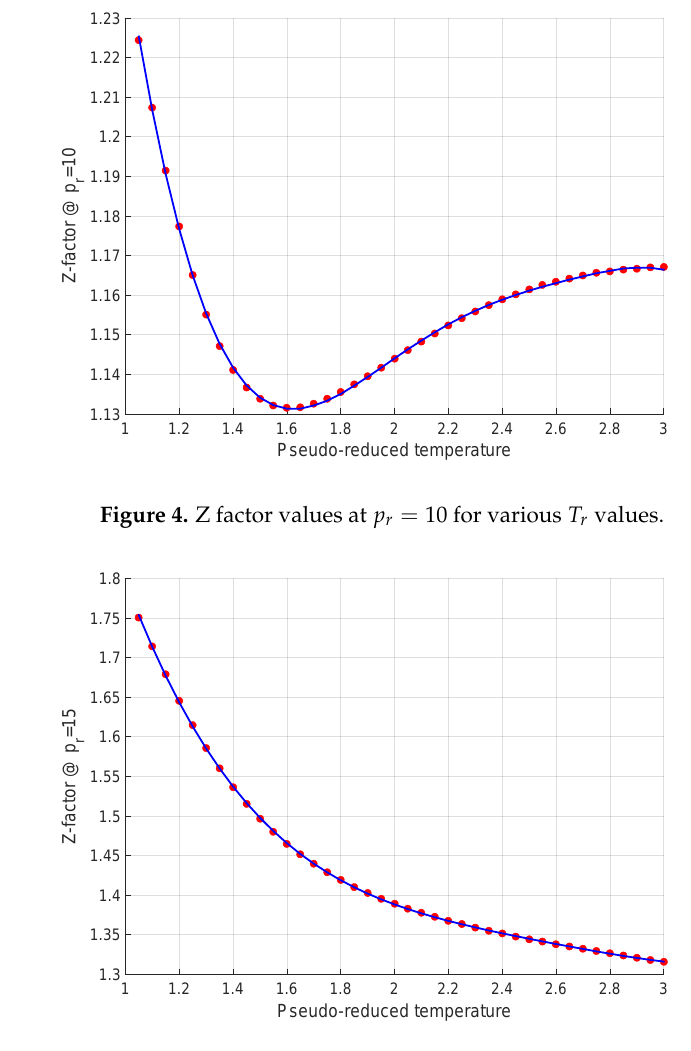
Figure 5. Z factor values at p r = 15 for various T r